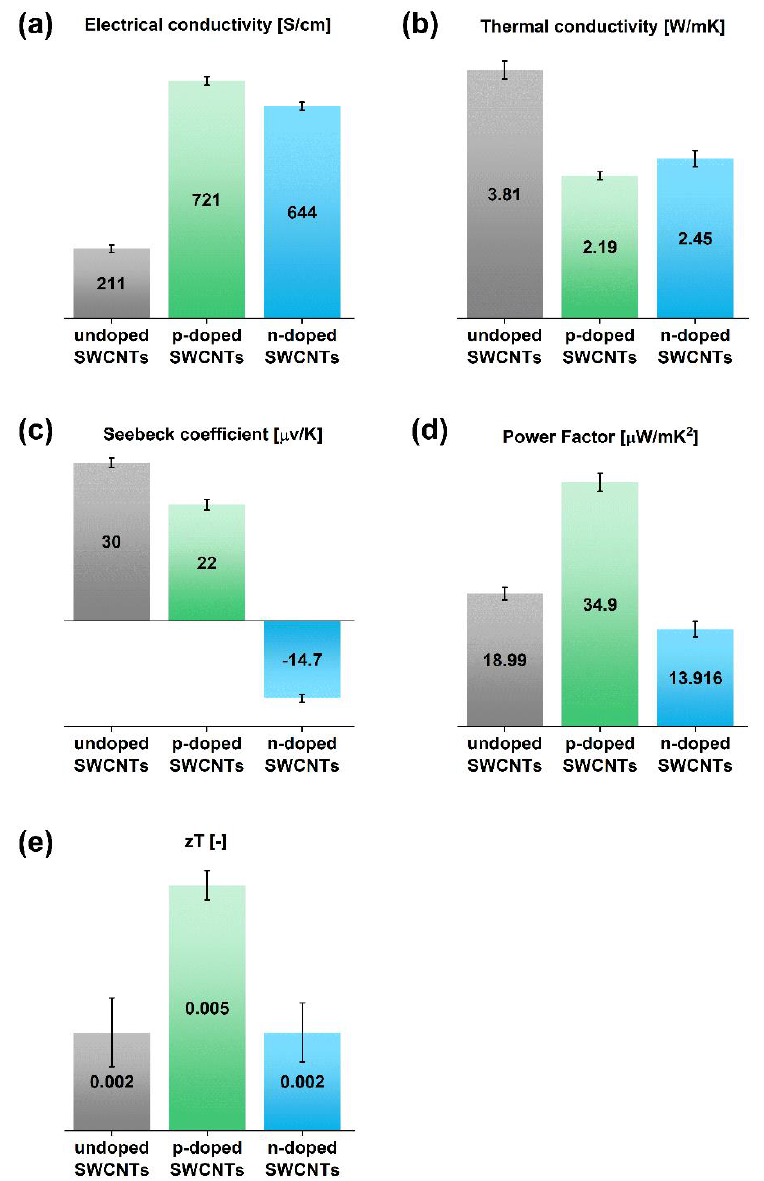
Figure 4. The impact of p- and n-doping of SWCNT films on the values of ( a ) electrical conductivity, ( b ) thermal conductivity, ( c ) Seebeck coefficient, ( d ) Power Factor, and ( e ) Figure of Merit. Meanwhile, the Seebeck coefficient decreased from 30 ± 0.90 µV/K to 22 ± 1.01 µV/K.